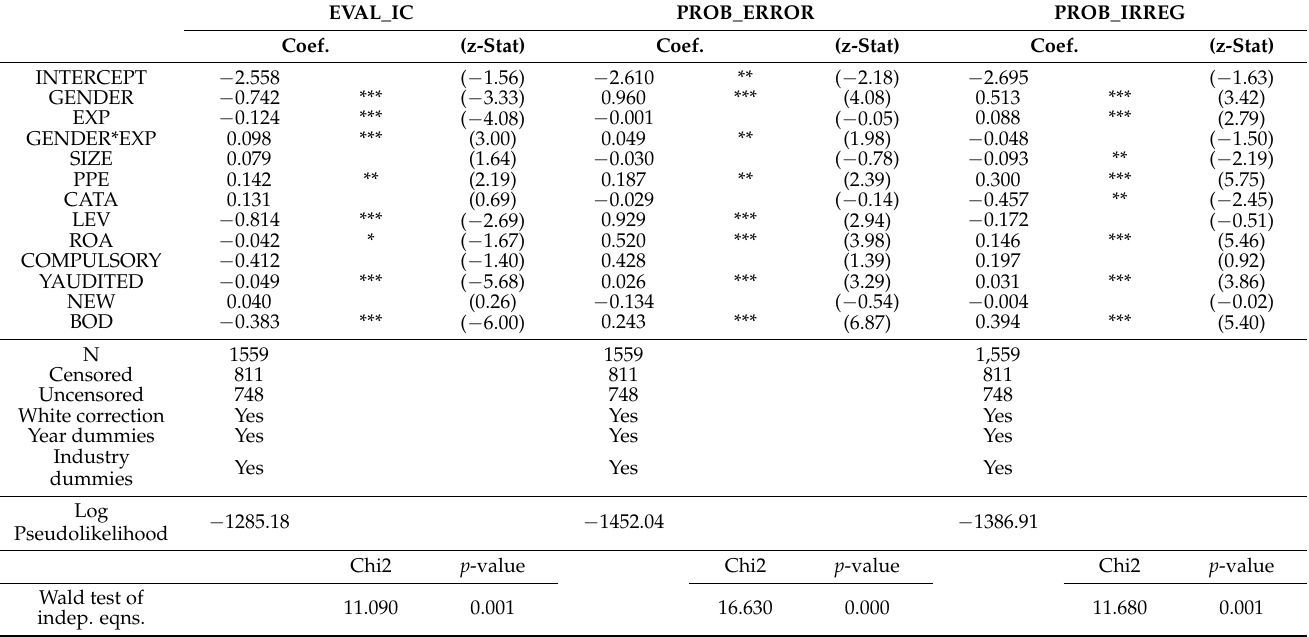
Table 2. Ordered probit sample selection results for Audit Risk Assessment